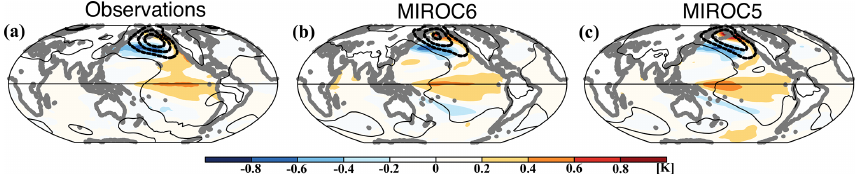
Figure 28. Same as Fig. 26, but for anomalies of monthly SST and wintertime SLP regressed onto the PDO index (see the text). COBE- SST2–SLP2 data in 1900–2013 are used as observations.